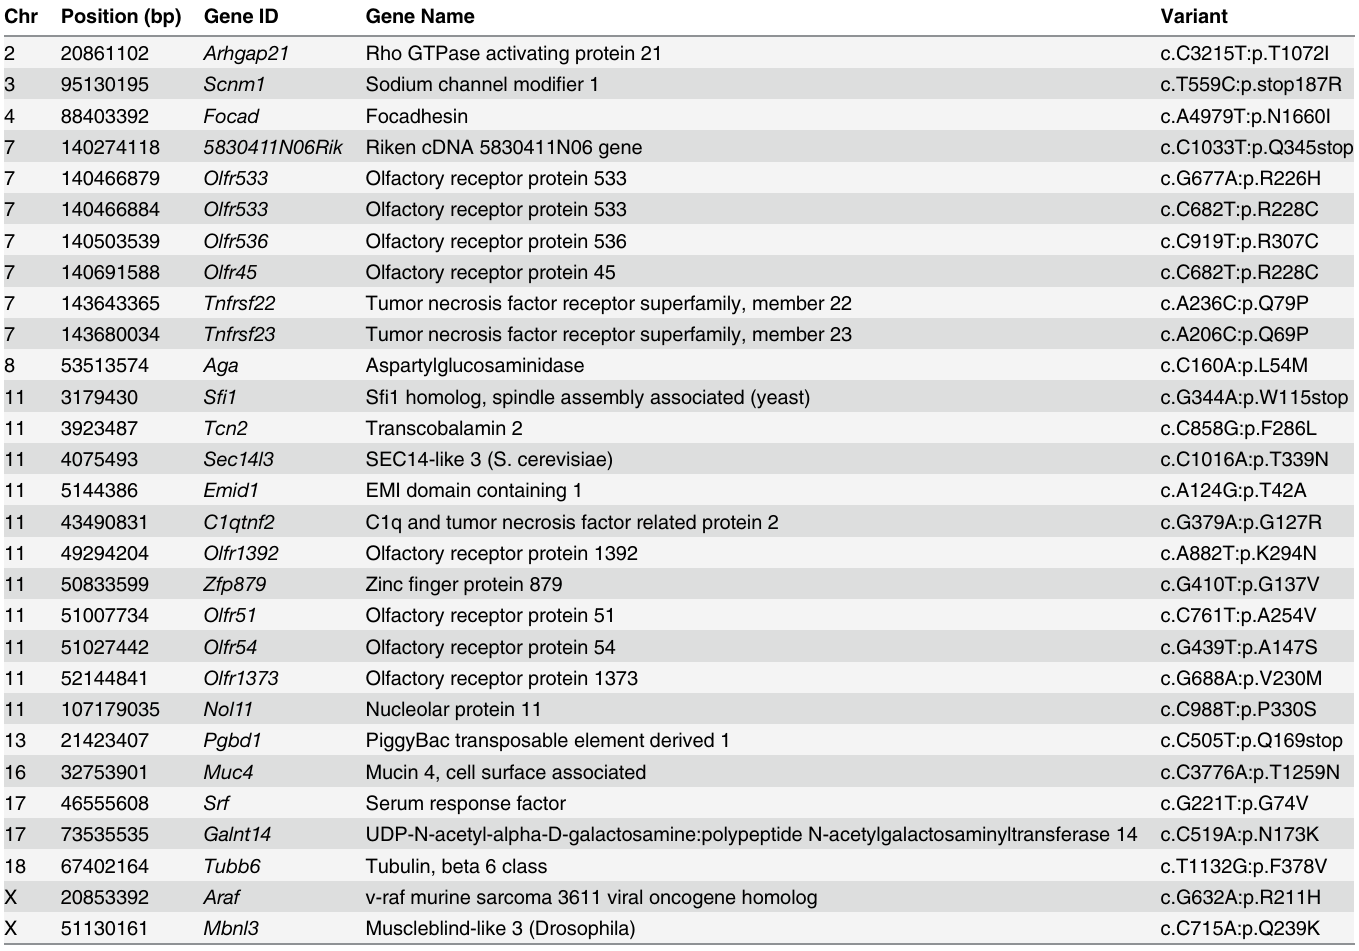
Table 1. KaLwRij novel germline missense, stoploss, and stopgain mutations. Chr Position (bp) Gene